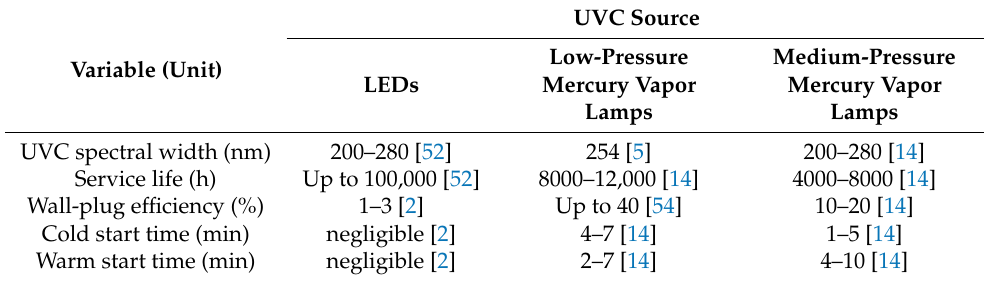
Table 5. A comparison of the technical properties of UVC LEDs and mercury lamps.